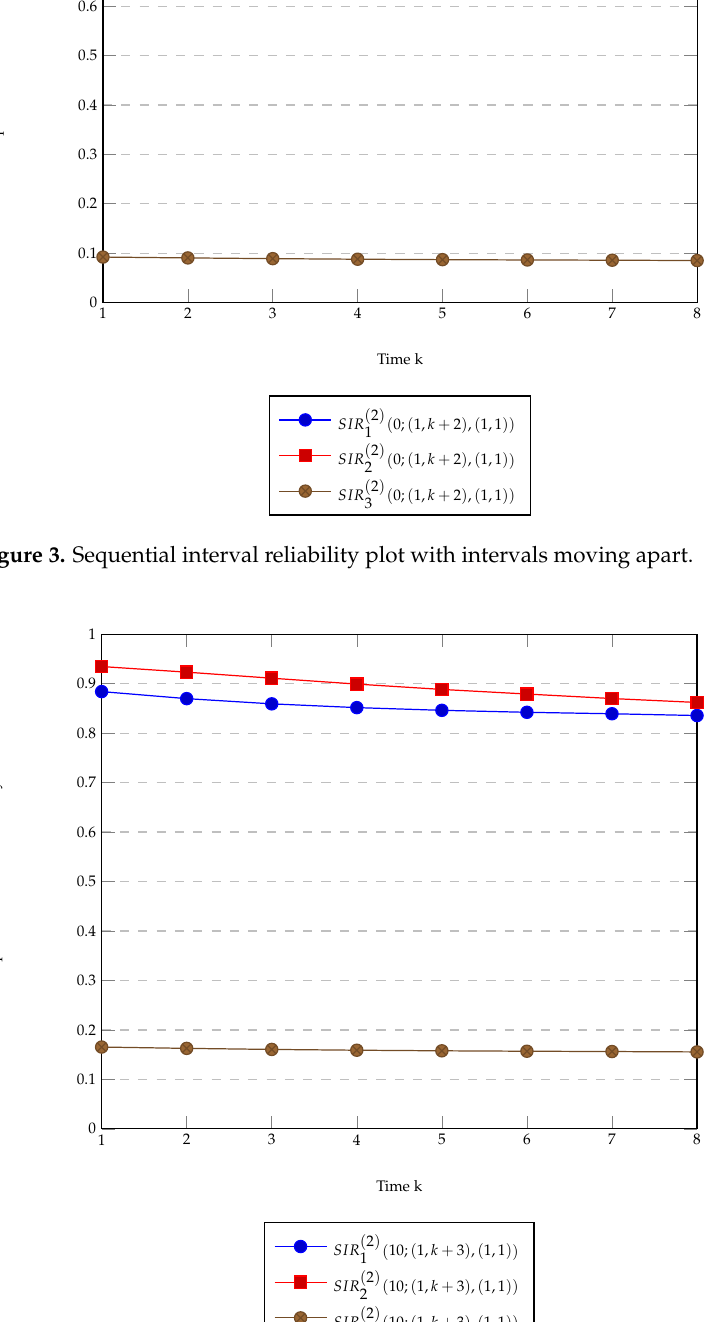
Figure 4. Sequential interval reliability plot with the initial backward ( v = 10) and intervals moving apart